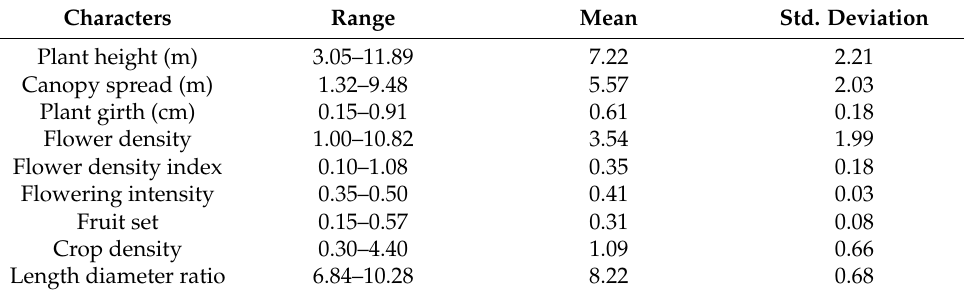
Table 1. Summary of plant